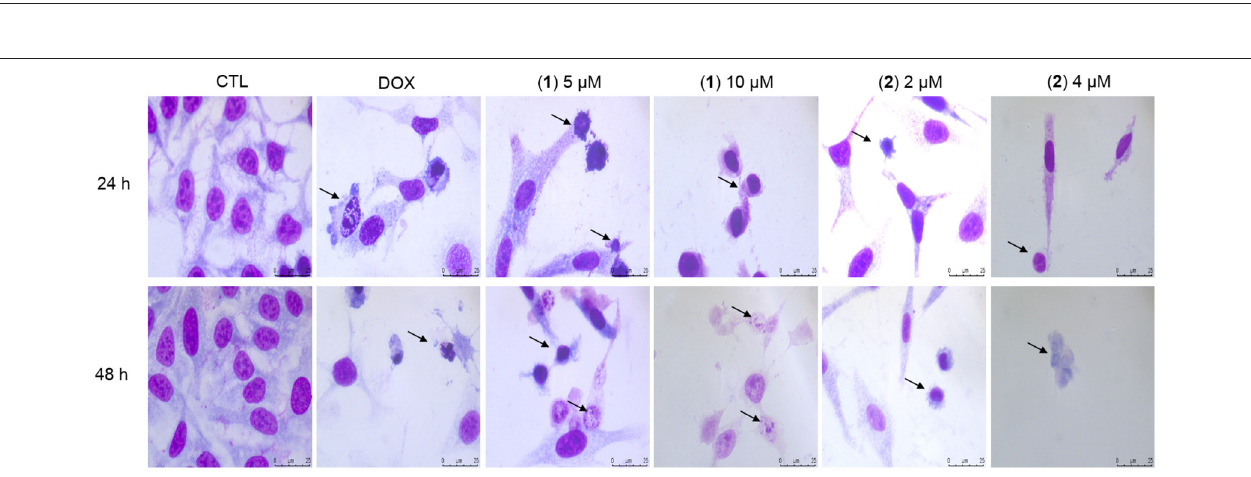
FIGURE 5 | Effect of ruthenium complexes containing heterocyclic thioamidates in the morphological analysis of HepG2 cells after 24 and 48h of incubation. The cells were stained with May-Grunwald-Giemsa and examined by light microscopy (bar = 20 µ m). The negative control (CTL) was treated with the vehicle (0.2% DMSO) that was used to solubilize and dilute the complexes, and doxorubicin (DOX, 2 µ M) was used as the positive control. Arrows indicate cell shrinkage or cells with fragmented DNA.